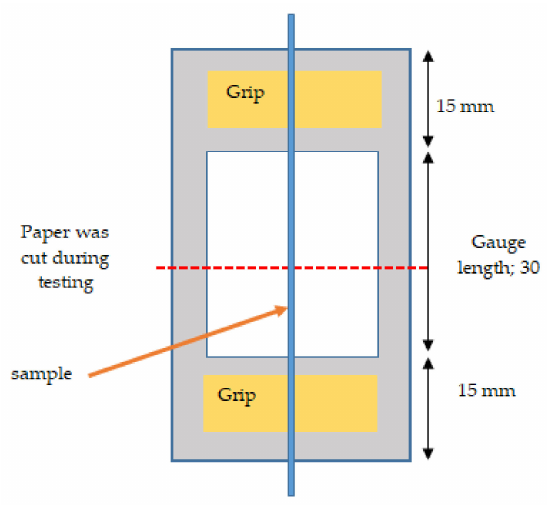
Figure 2. Schematic layout of the single kenaf